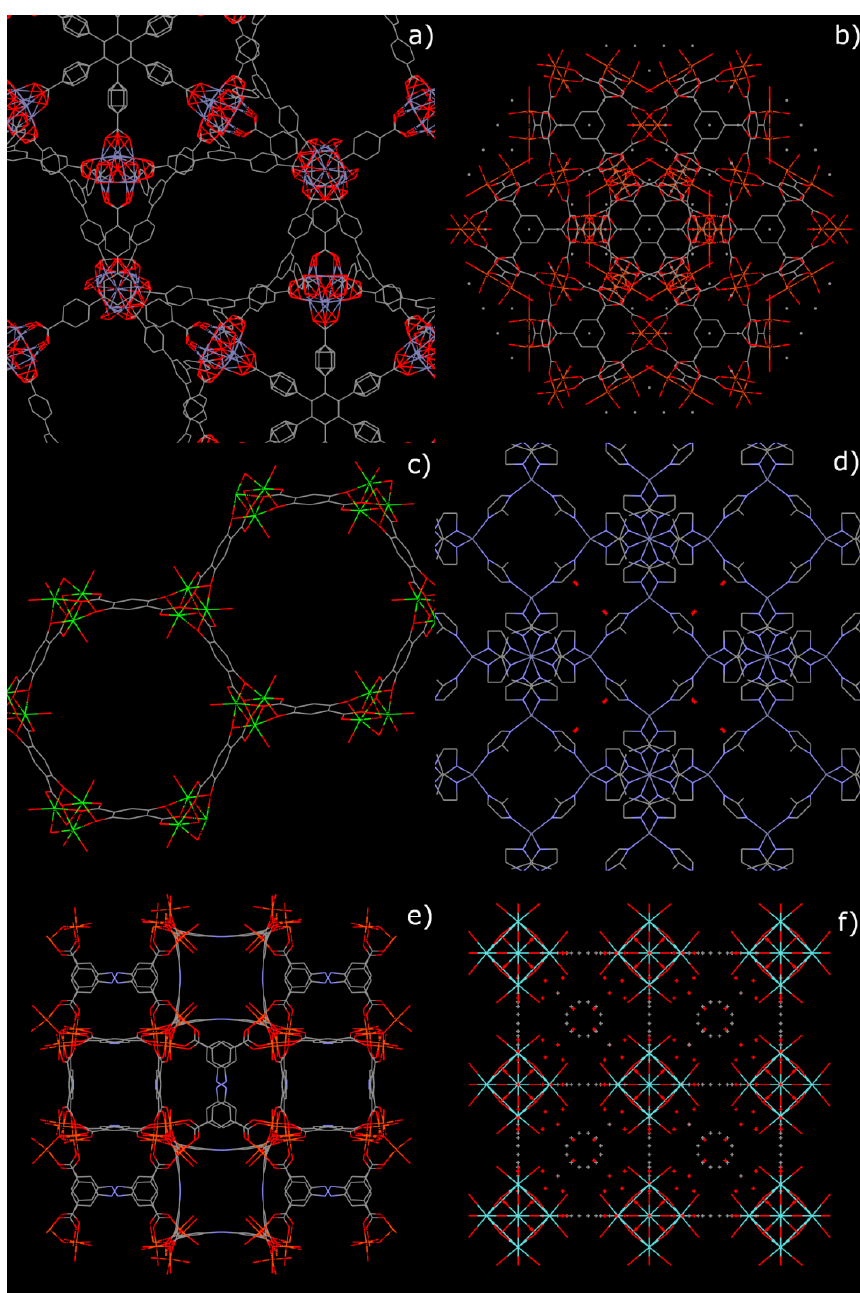
Figure 1. Crystal structures of some mass-produced metal–organic frameworks (MOFs): ( a ) MOF-177; ( b ) Cu-BTC; ( c ) Mg-MOF-74; ( d ) ZIF-8; ( e ) PCN-250 (Fe 3 ); ( f ) UiO-66.